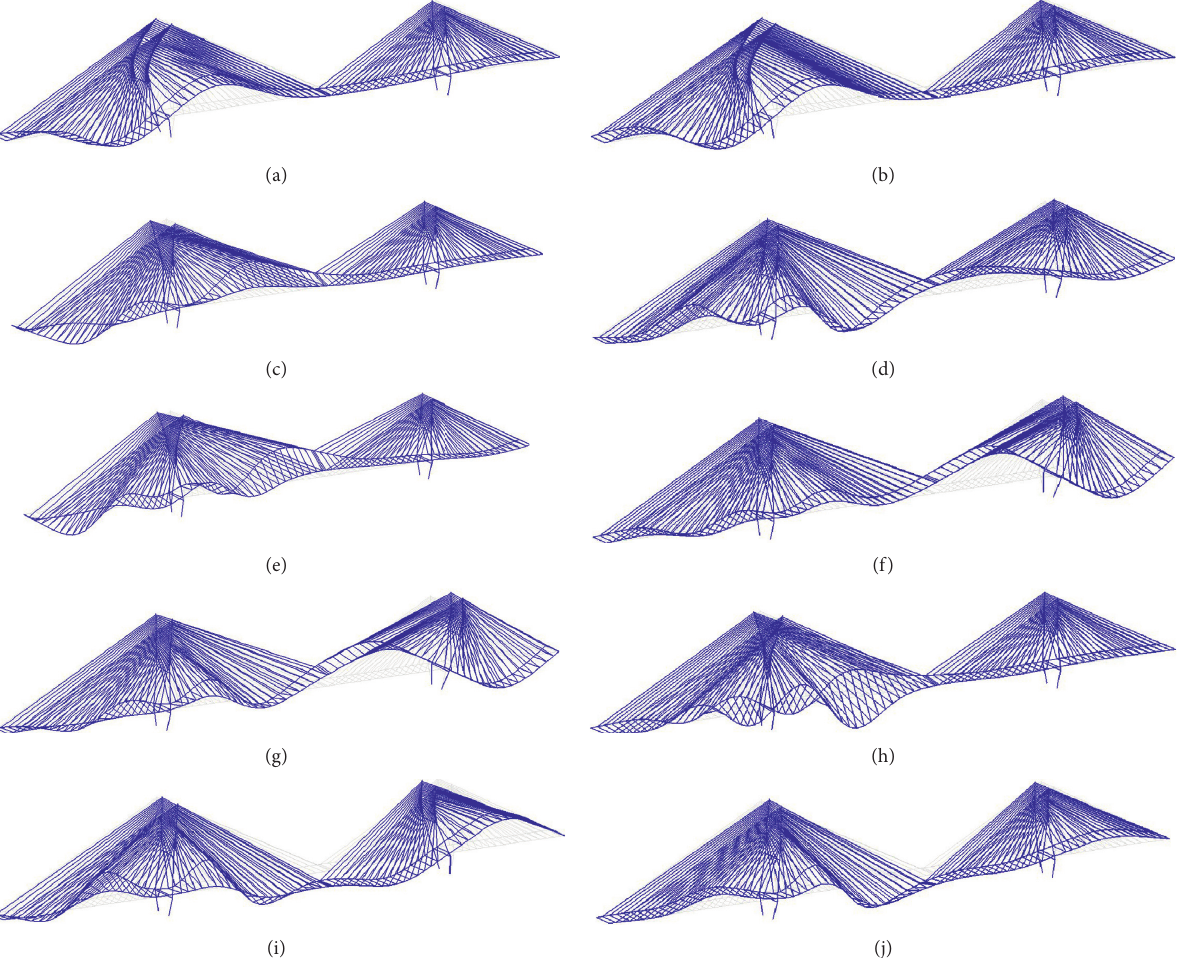
Figure 19: Low-order instability shapes for different cases. (a) 1 st order for damaged case. (b) 1 st order for emergency rescue case (repair scheme 2). (c) 2 nd order for damaged case. (d) 2 nd order for emergency rescue case (repair scheme 2). (e) 3 rd order for damaged case. (f) 3 rd order for emergency rescue case (repair scheme 2). (g) 4 th order for damaged case. (h) 4 th order for emergency rescue case (repair scheme 2). (i) 5 th order for damaged case. (j) 5 th order for emergency rescue case (repair scheme